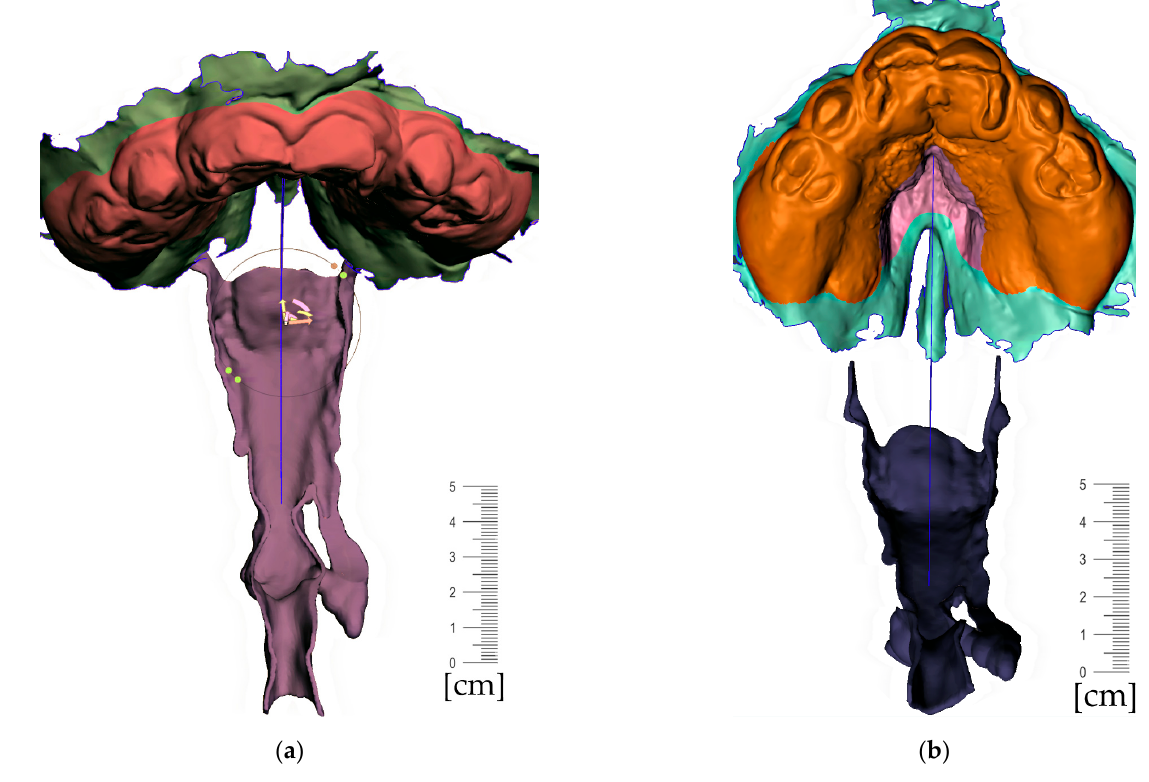
Figure 11. Pharyngeal part creation—the spur. Midline and axis identification: ( a ) frontal view—the midline of the future spur shall be centered; ( b ) palatal view of the midline of future spur shall be connecting the future appliance’s alveolar body symmetrically in the middle of the alveolar arch.